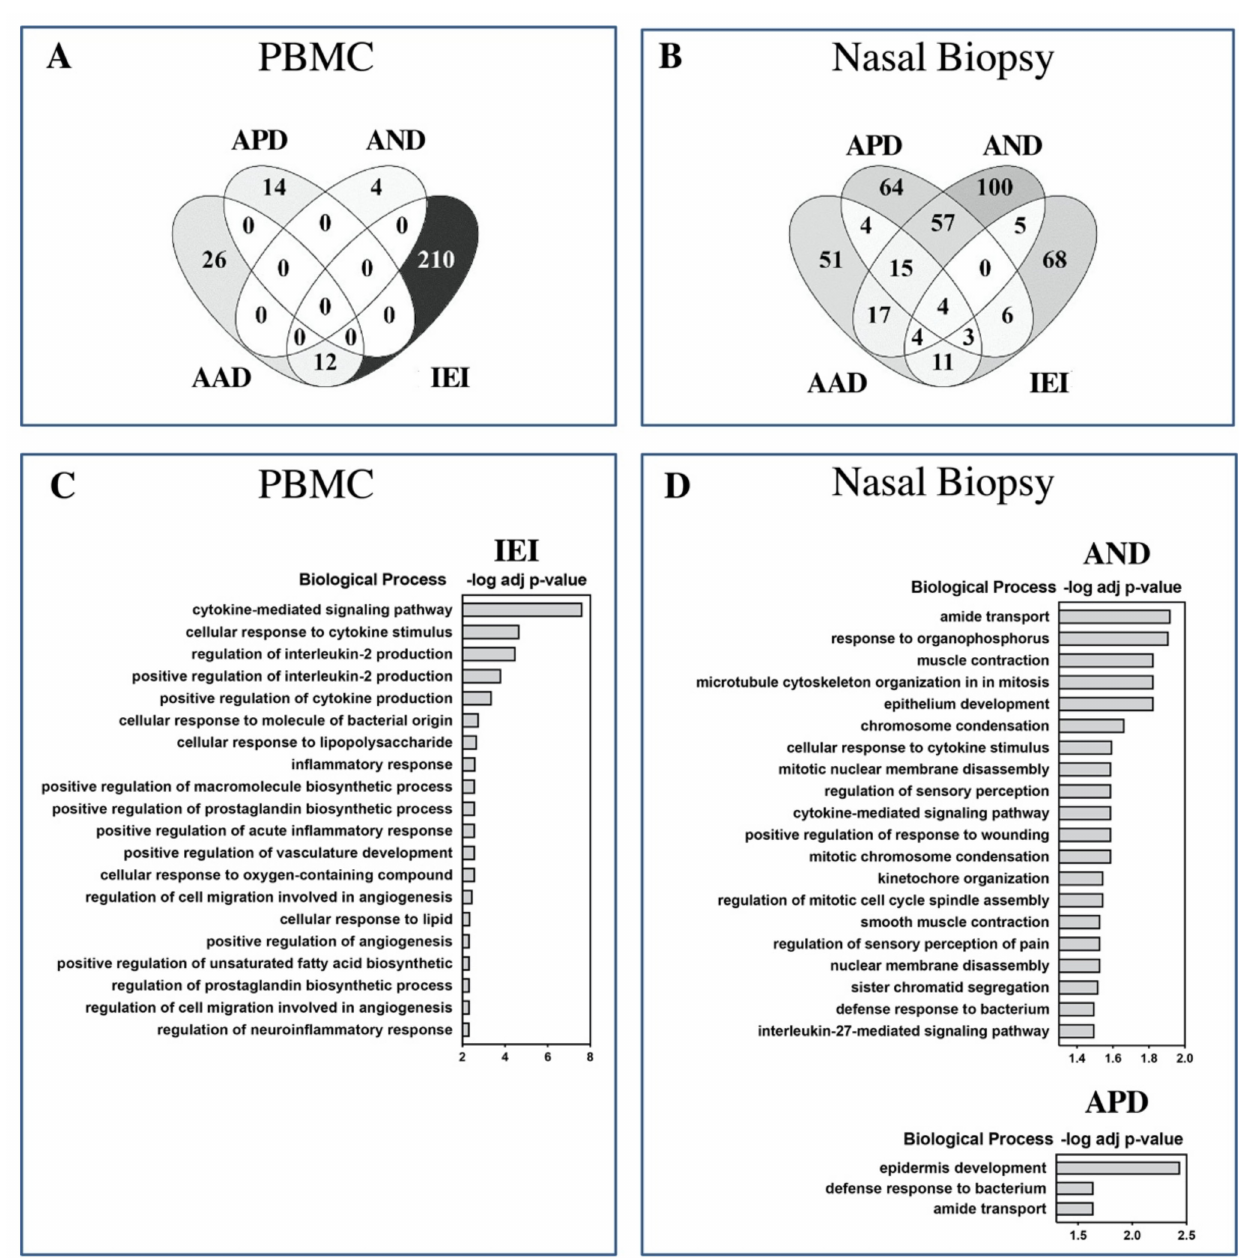
Figure 3. Venn diagram of differentially expressed genes (DEGs) identified in patient versus controls in PBMC ( A ) and nasal biopsy ( B ). Patient groups with asthma that is associated to dampness and molds, possibly associated to dampness and molds, and not associated with dampness and molds are denoted as AAD, APD, and AND, respectively. Patients diagnosed with idiopathic environmental intolerance are denoted as IEI and controls are denoted as C . AND and APD had the greatest number of shared DEGs in nasal biopsy, while AAD and IEI have the most DEGs in common in blood cells (PBMC). Gene ontology-based analysis of enriched biological processes in different patient groups reveals several significantly overrepresented pathways. The top pathways, ranked by − log adjusted p value (cutoff, 1.3) are shown for each differentially expressed gene set identified in PBMC ( C ) and nasal biopsy ( D